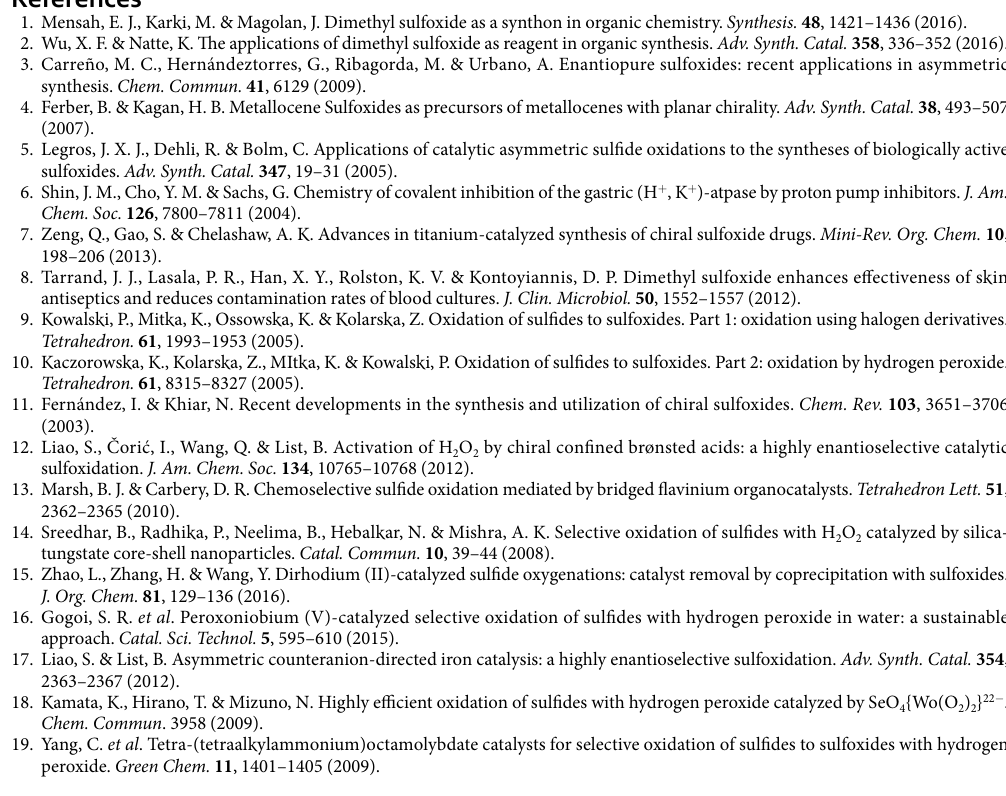
Methods Synthesis of methyl phenyl sulfoxide (3a).